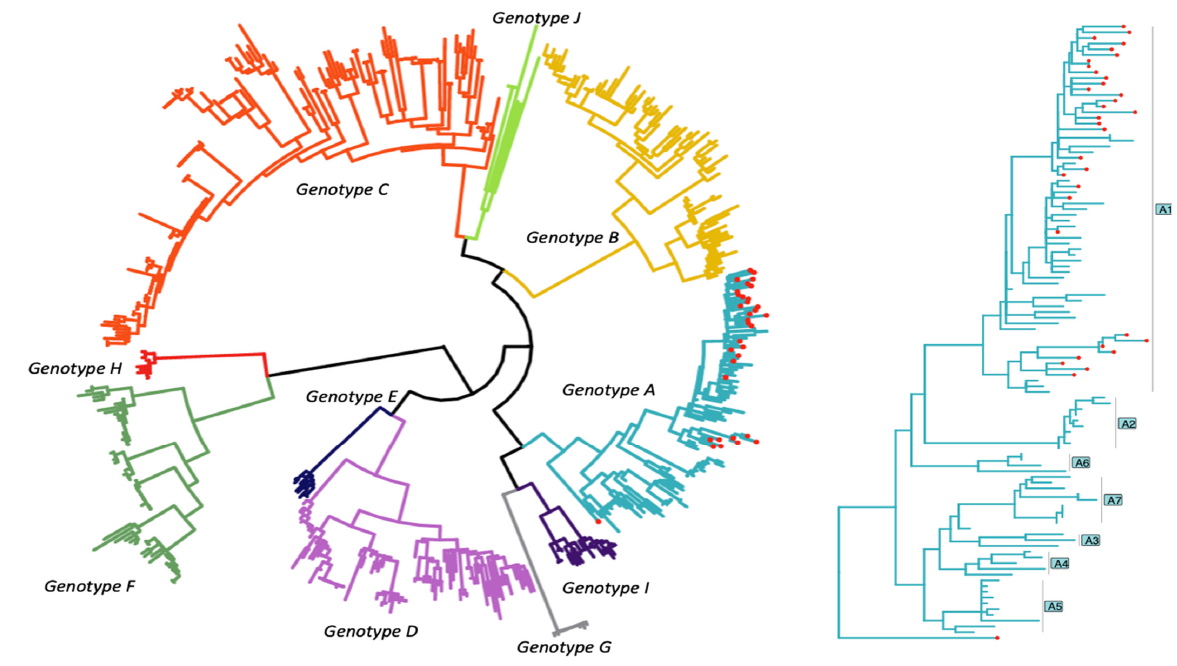
Figure 3. Maximum likelihood phylogenetic tree showing ten HBV genotype references and an expansion of genotype A with study sequences represented by red dots. Booster support values (>0.95) for major branches.